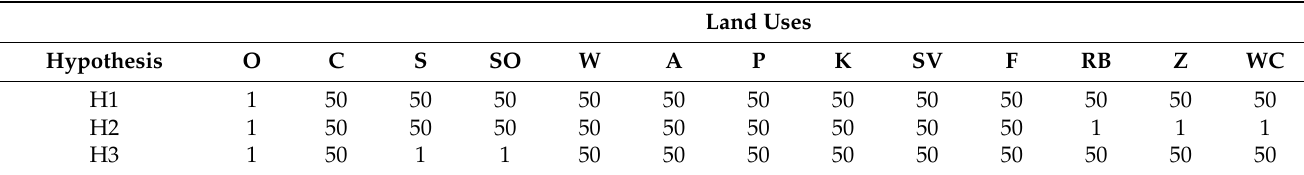
Table 1. Cost values assigned to land uses according to three hypotheses regarding their suitability for Bactrocera oleae (see text for details). O: olive grove, C: field crop, S: scrubland, SO: scrubland with oaks, W: woody crop, A: artificial, P: pastures, K: oak forest, SV: sparse vegetation, F: pine forest, RB: riverside vegetation, landscape mosaic (Z), watered crop